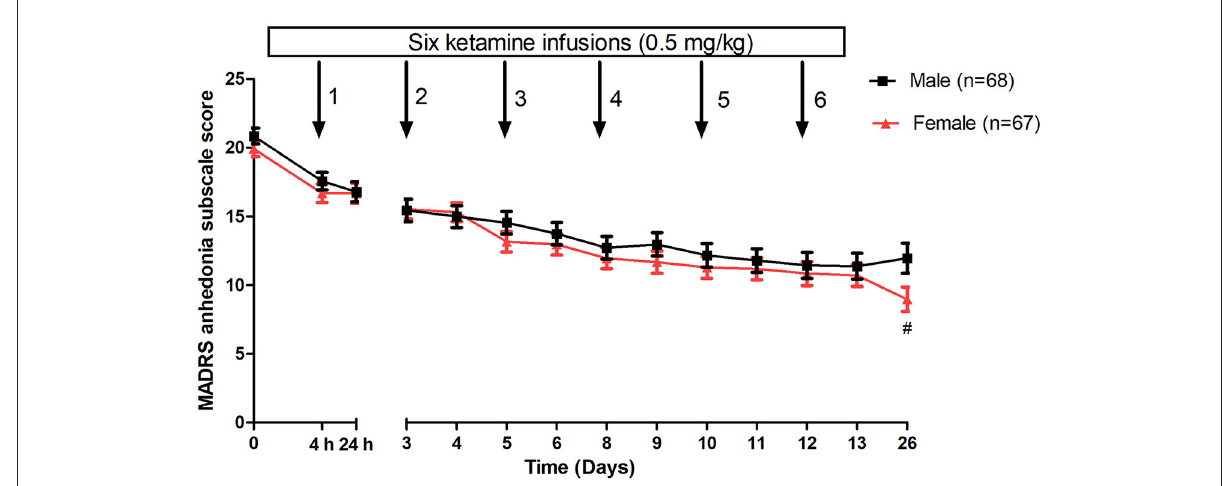
FIGURE1 Gender differences in changes in anhedonia symptoms in patients with depression following multiple ketamine infusions. All values are presented as mean ± standard error. # A significant difference was found at a given time point between women and men with depression ( p < 0.05). MADRS, Montgomery-Åsberg Depression Rating